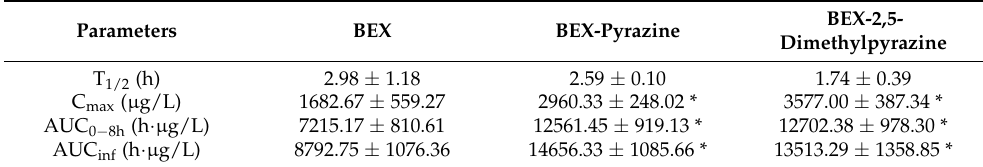
Table 2. Pharmacokinetic parameters of BEX and cocrystals in rats.